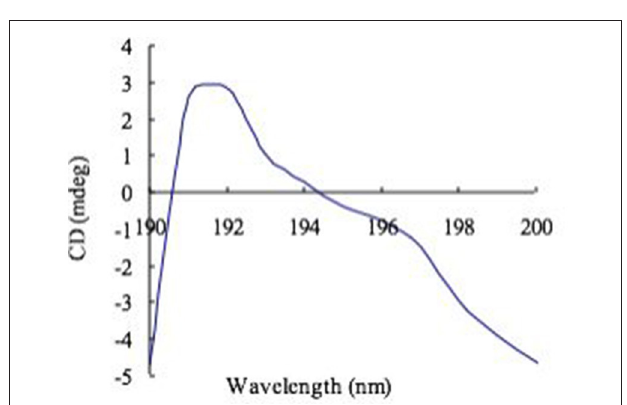
TABLE 2 | GC-MS analysis for methylation of exopolysaccharide from S. commune.